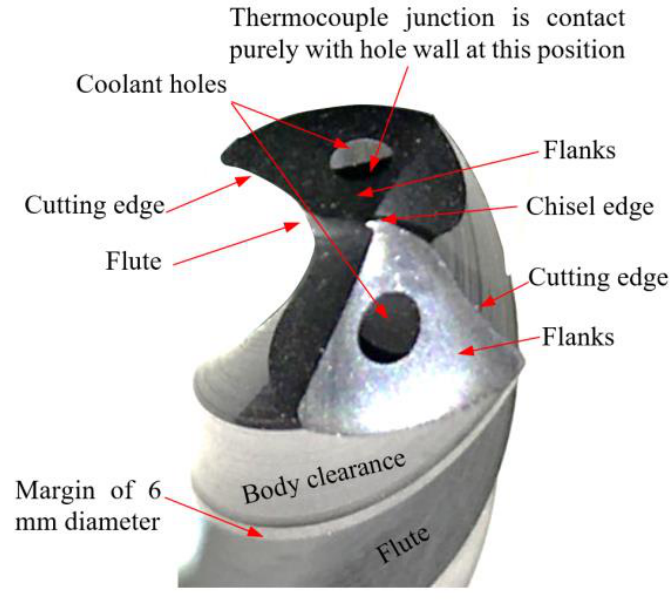
Figure 1. Different elements of the cemented carbide drill. Table 3. Geometries of the cemented carbide drills.